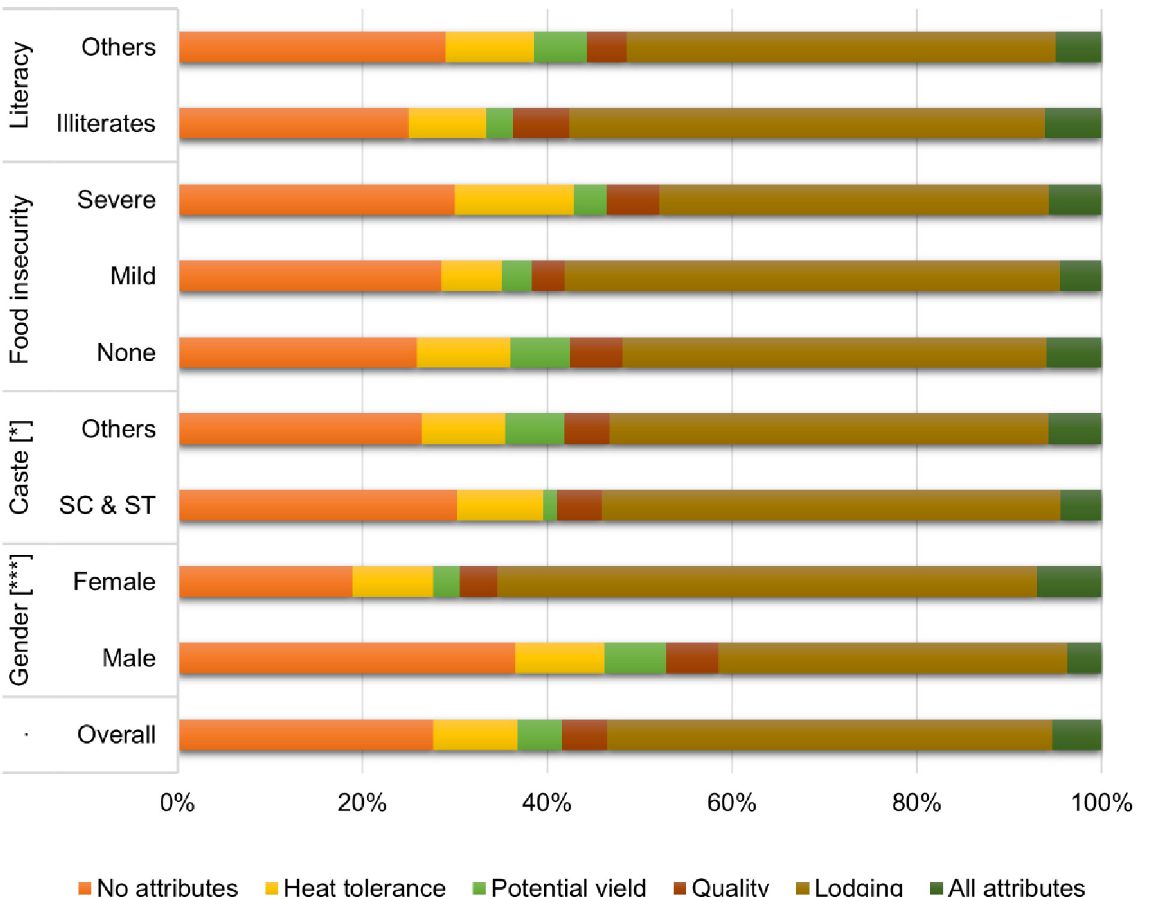
Fig 2. Attribute non-attendance among respondent groups. Note: ��� and � represent statistically significant difference in the distribution of categories of attribute non-attendance between the sub-groups at 0.01 and 0.10 levels, respectively.